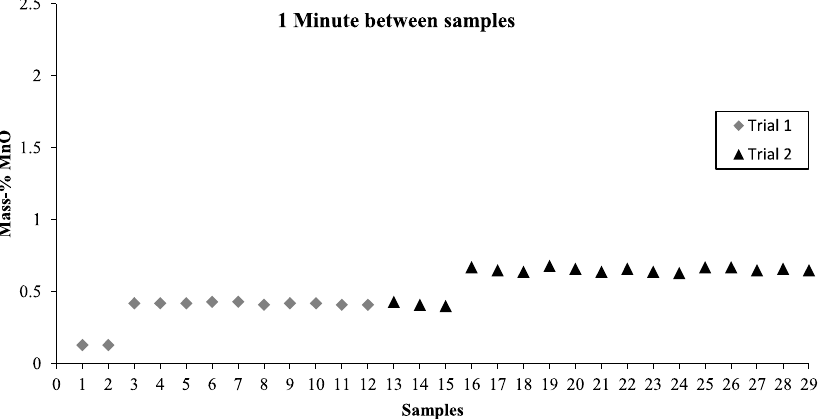
Figure 2. Content MnO (%) for the different samples for Trial 1 and Trial 2, respectively. The MnO 2 powder was added after sample 2 for Trial 1 and after sample 15 for Trial 2 .